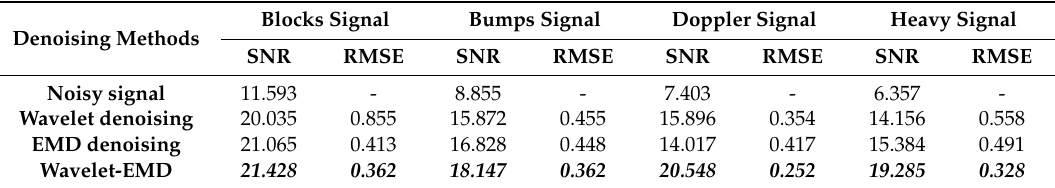
Table 1. Denoising results from the di ff erent methods.